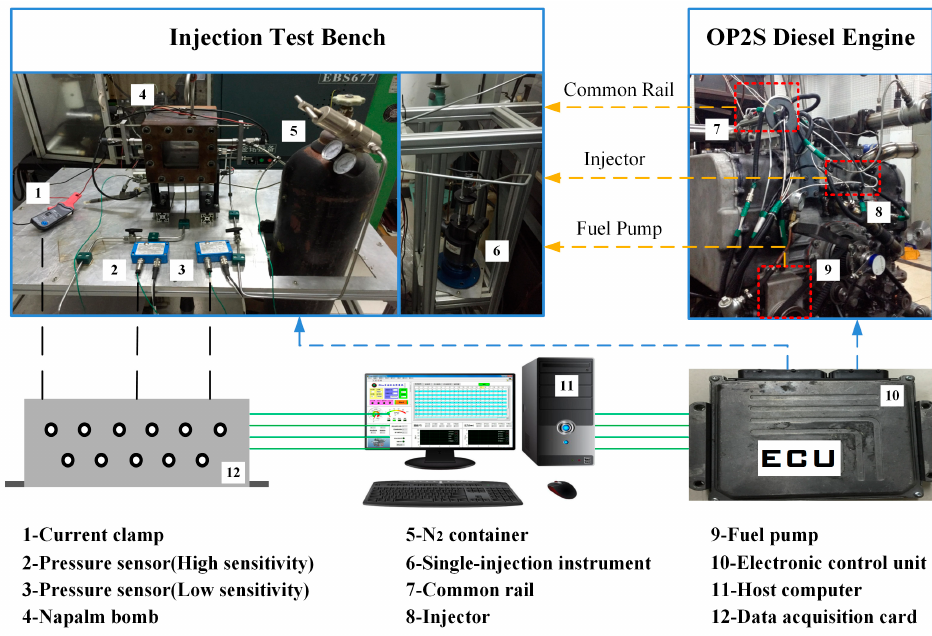
Figure 1. Experimental prototype test bench and measurement equipment.